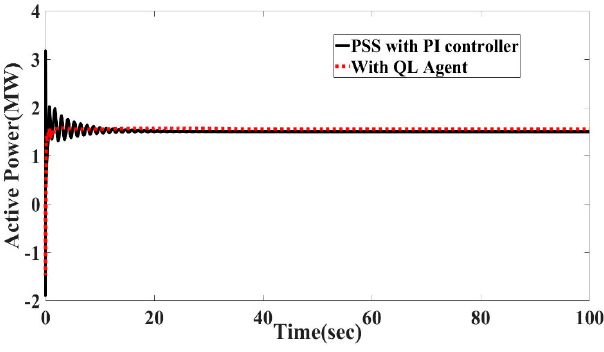
Figure 24 . Active power with PI controller vs. Q ‐ learning.